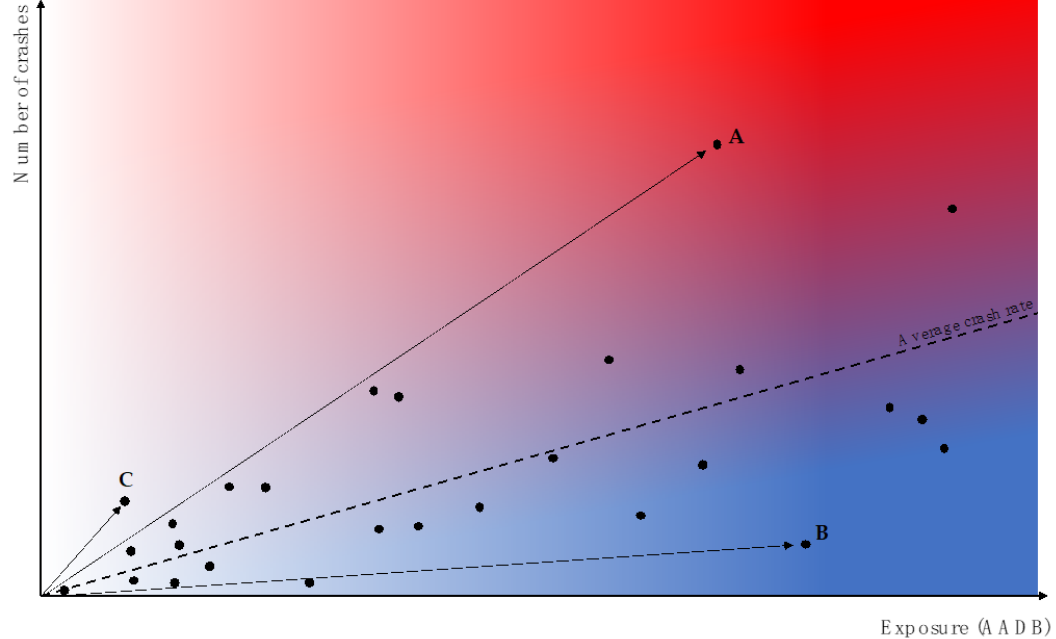
Figure 9. Comparison of the number of crashes to the cycling exposure. Each point represents different a road segment facility (simulated, not based on real data). This plot provides additional information than just using crash rates.